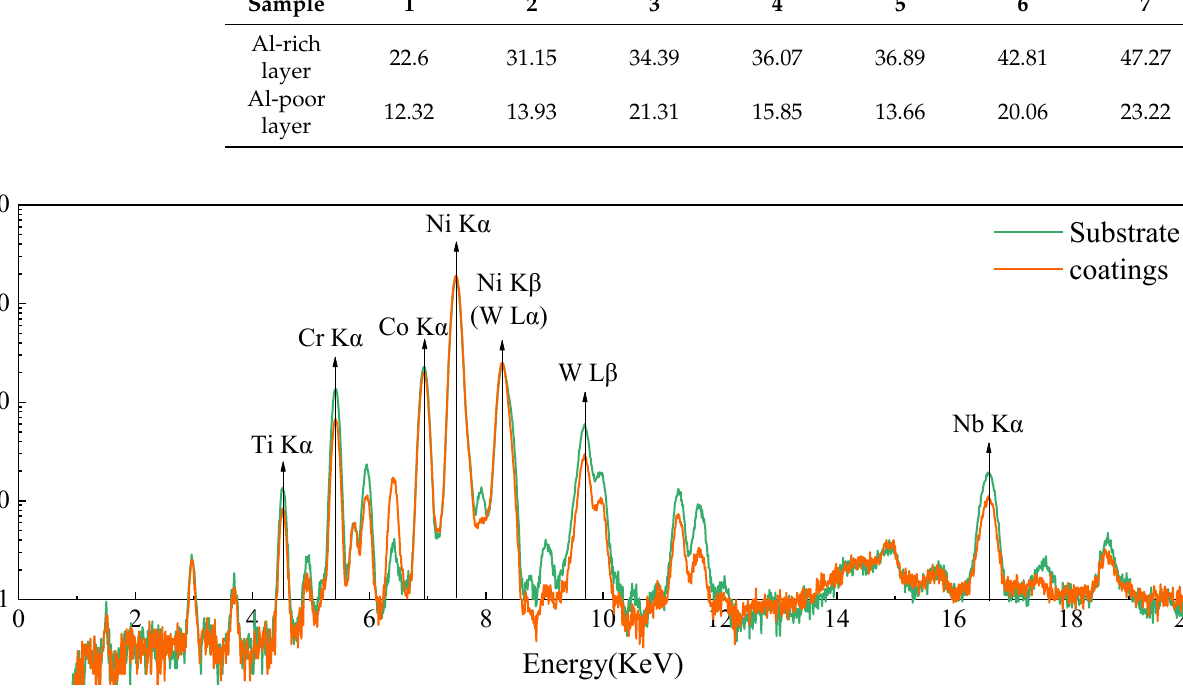
Figure 7. Spectral comparison of coating and substrate material.